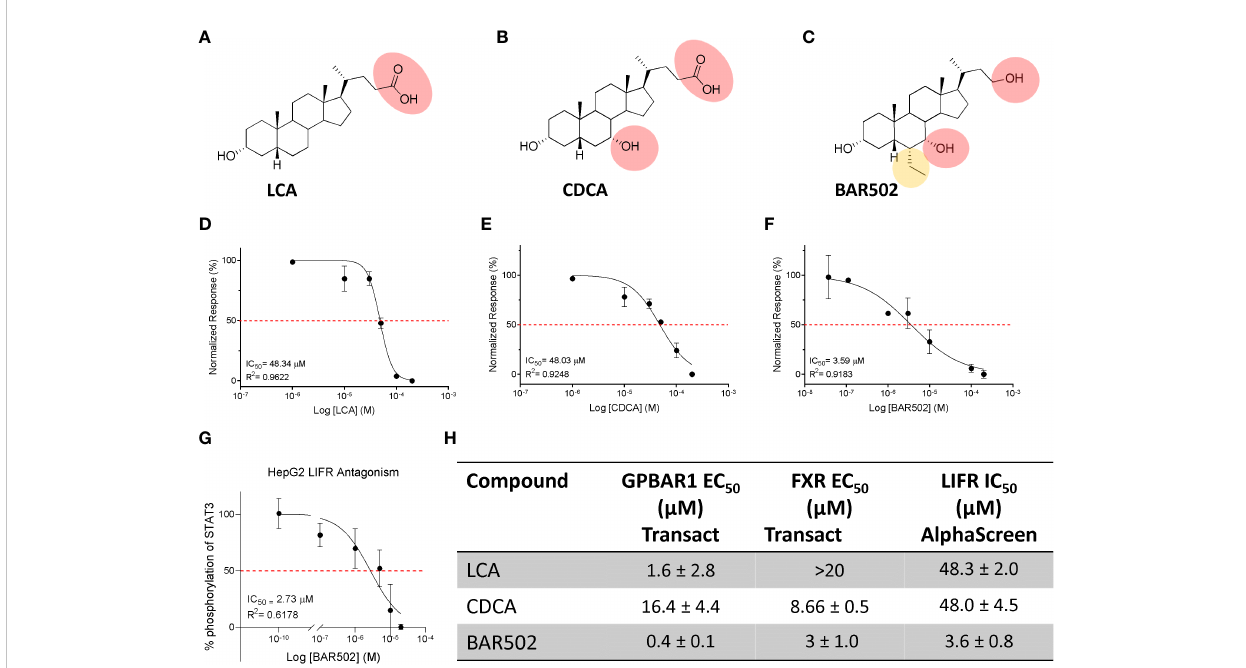
FIGURE 2 Natural and synthetic bile acids antagonize LIFR. The fi gure shows two-dimensional structure of (A) LCA (B) CDCA (C) BAR502. Natural and synthetic bile acids inhibition activity of LIFR/LIF binding accessed by a cell-free AlphaScreen assay, particularly in (D) LCA (E) CDCA and (F) BAR502 IC 50 are shown. (G) STAT3 transactivation on HepG2 cells. The table (H) summarizes EC50 on FXR and GPBAR1 and IC